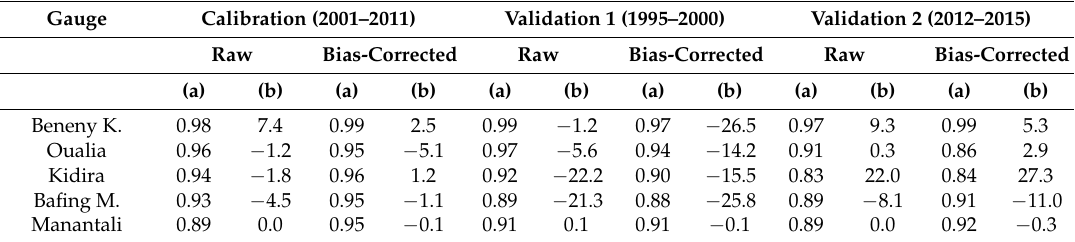
Table 7. Summary of numerical criteria over calibration and validation